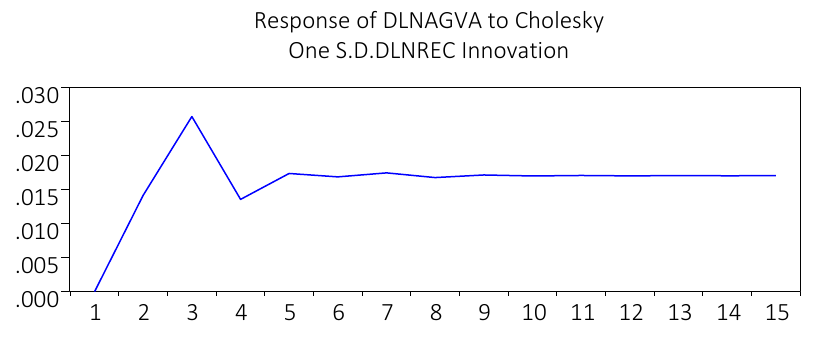
Figure 2a. CO policy response on agricultural development by 2030 (SDG agenda) 2